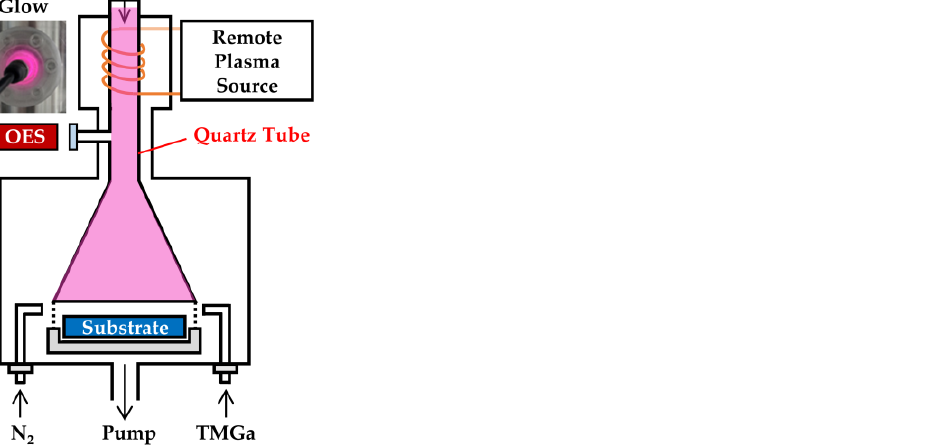
Figure 11. The schematic plot of the deposition chamber and OES detector location. Table 2. Detailed deposition parameters of the GaN films.